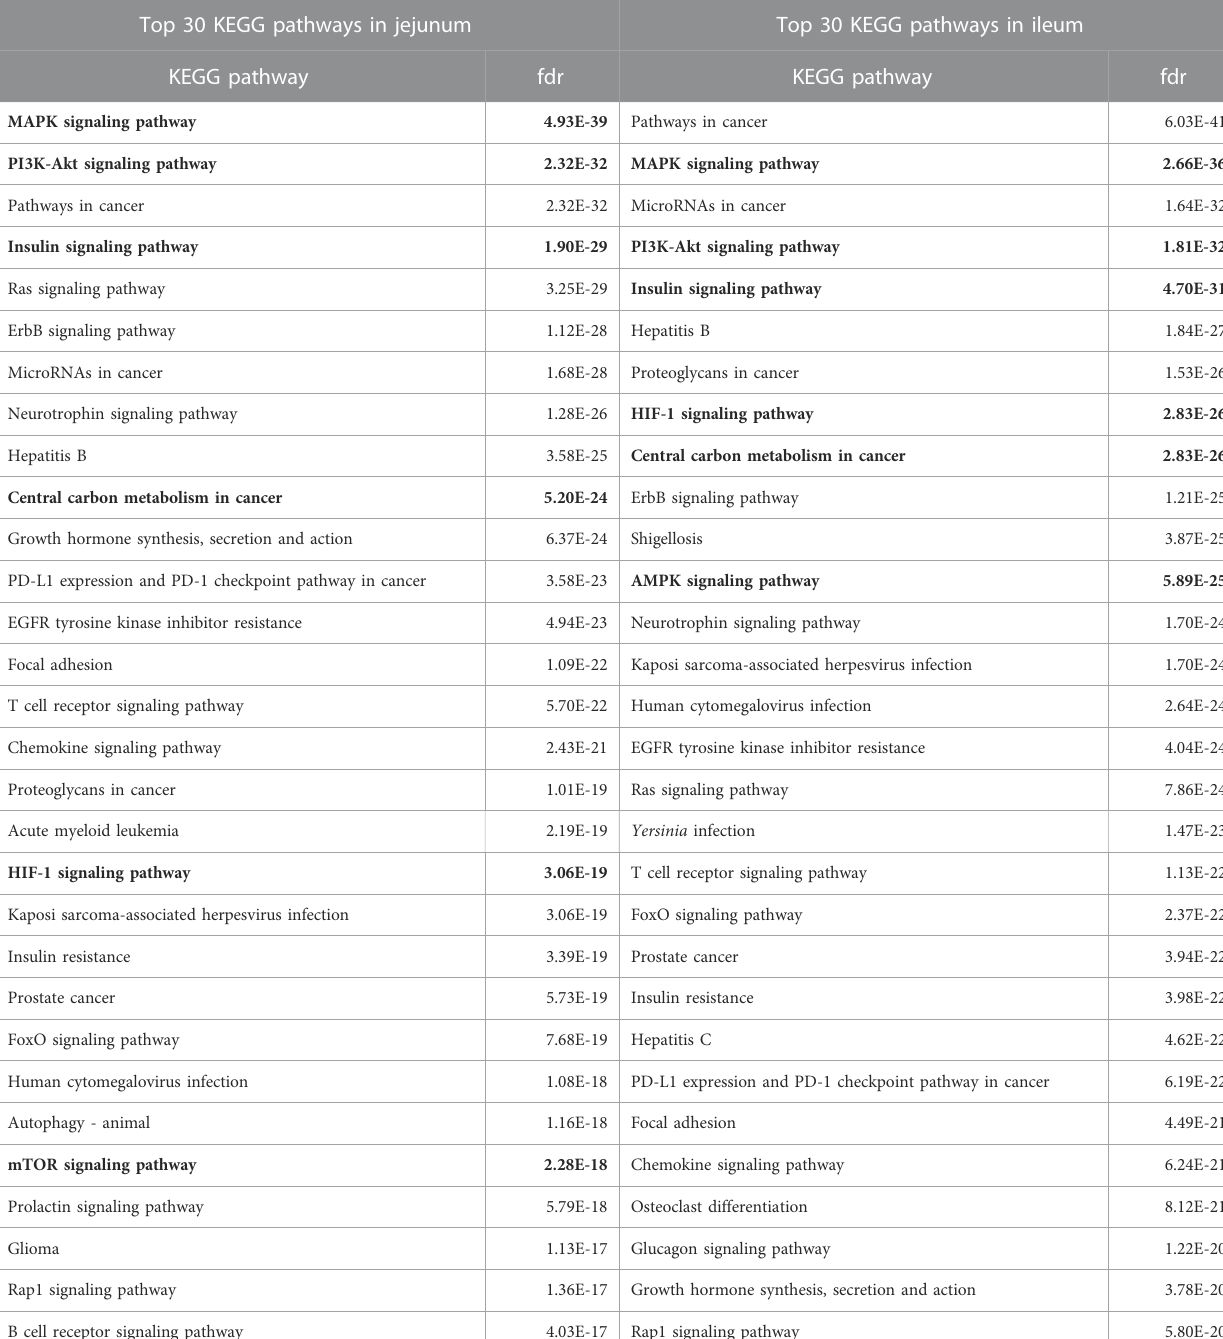
TABLE 2 Top 30 KEGG Pathways Enriched in Jejunum and Ileum. The top 30 KEGG pathways, as determined by STRING, for each tissue are represented here. Proteins showing statistically signi fi cant differentialphosphorylation status between treatmentandcontrolfed birds for eachtissuewere provided to STRINGfor protein-protein interaction analysis. False Discovery Rate (fdr) is a signi fi cance metric ( p -value) provided by STRING. p -values are generated using the Benjamini – Hochberg procedure. Key pathways in immune and metabolic regulation have been